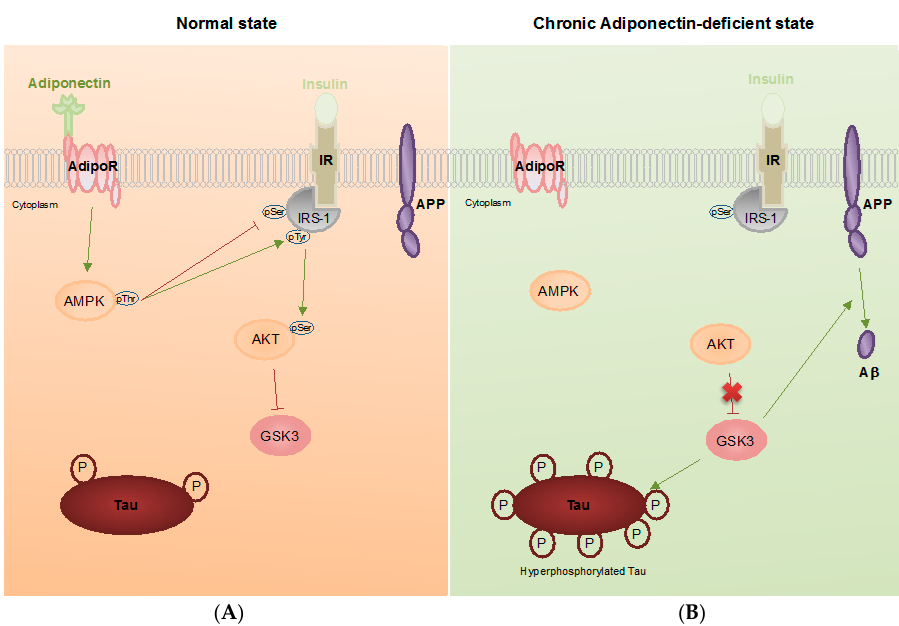
Figure 1. Pathophysiological roles of adiponectin in Alzheimer’s disease (AD). Schematic outline of neuronal adiponectin signaling in the normal brain ( A ); and adiponectin-deficient brain ( B ). Under physiological conditions, adiponectin binds to its receptor and triggers phosphorylation of AMPK which inhibits IRS-1 phosphorylation at serine residues. This increases insulin-mediated IRS-1 phosphorylation at tyrosine residues and promotes downstream Akt-mediated GSK3 inhibition. Inhibition of GSK3 slows down phosphorylation of Tau and APP metabolism. In AD, chronic adiponectin deficiency leads to an increase of IRS-1 phosphorylation at serine residues (e.g., Serine 616). This causes reduced pIRS-1Tyr and results in GSK3 activation. Activated GSK3 enhances Tau phosphorylation and A β production in neurons. Arrows denote promotion, T-bars denote inhibition.